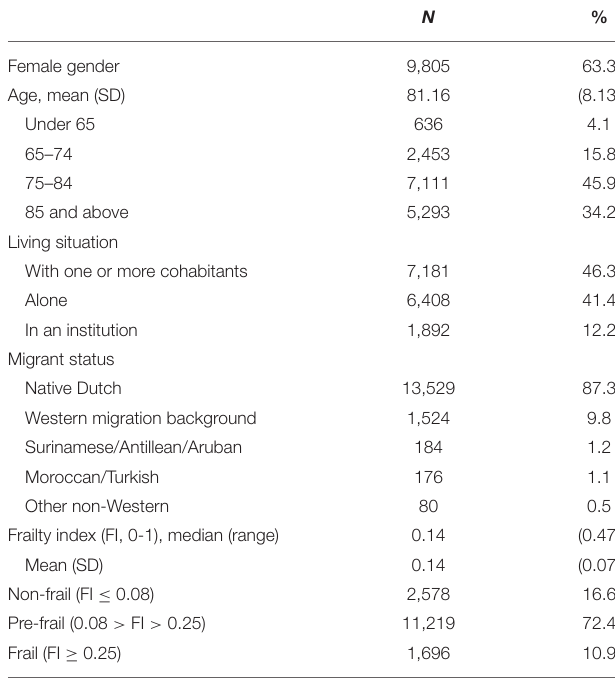
TABLE 1 | Characteristics of persons with dementia ( n = 15,493).